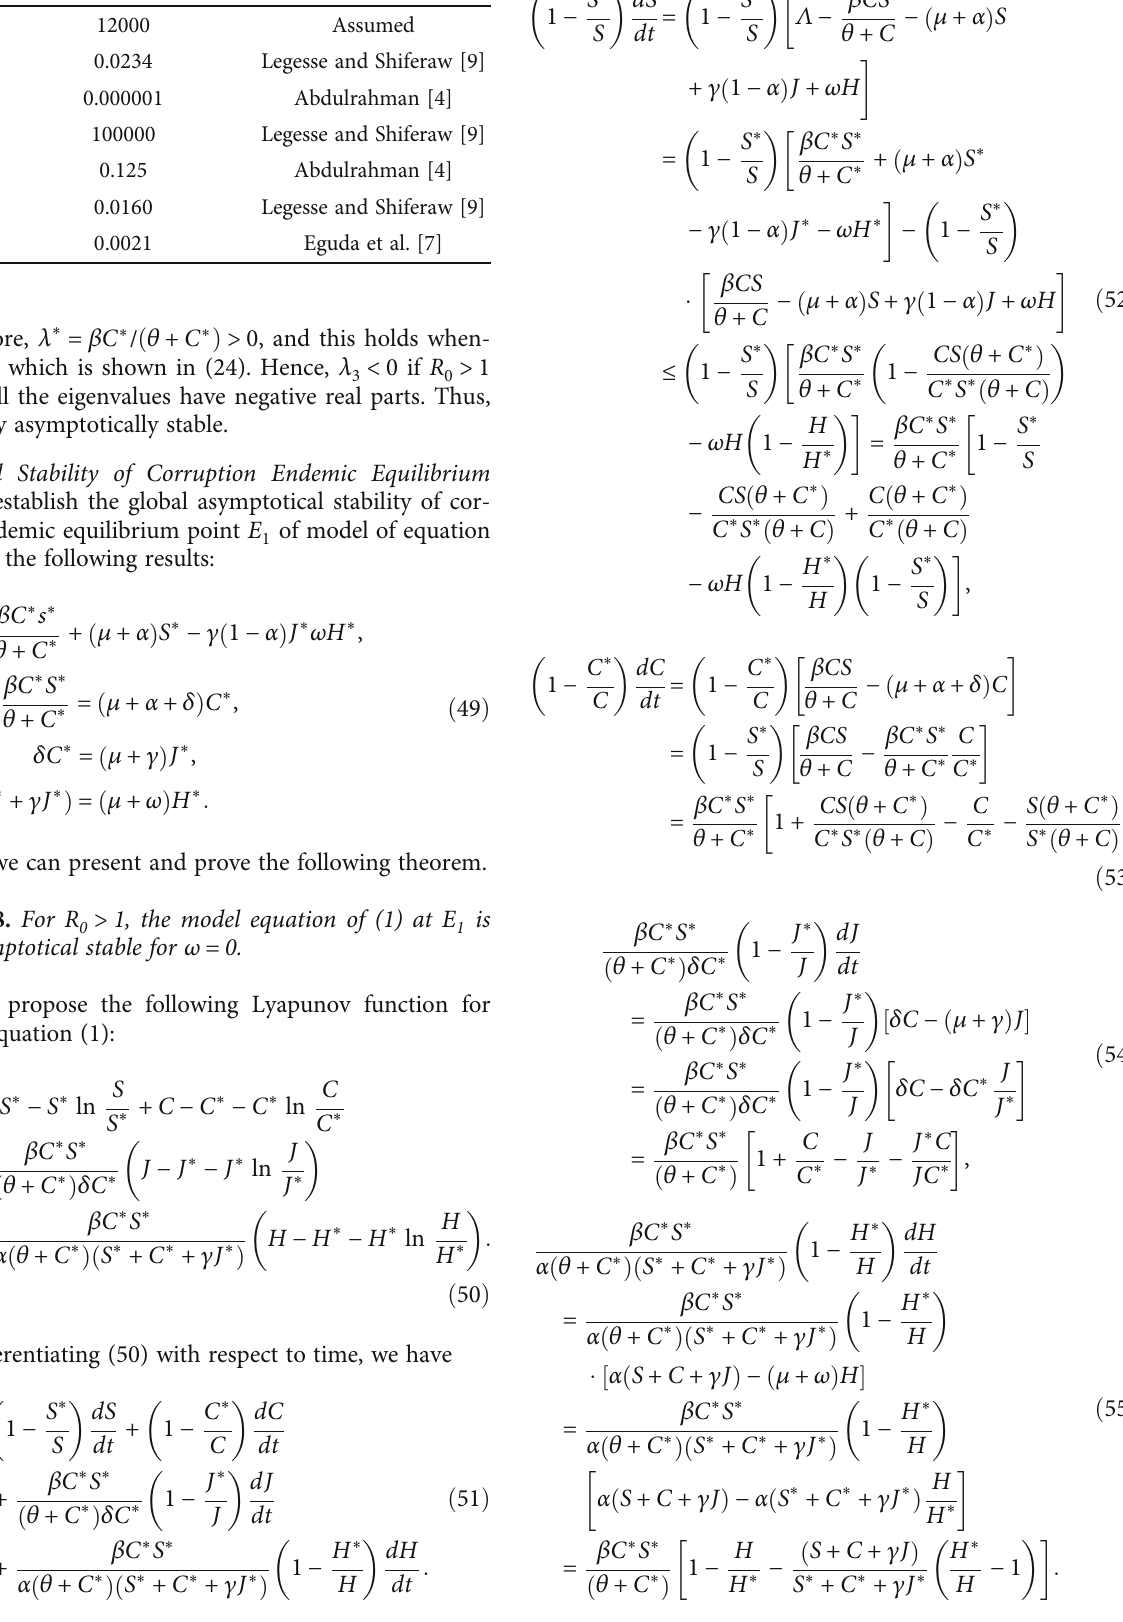
Table 2: The parameter values of the model.